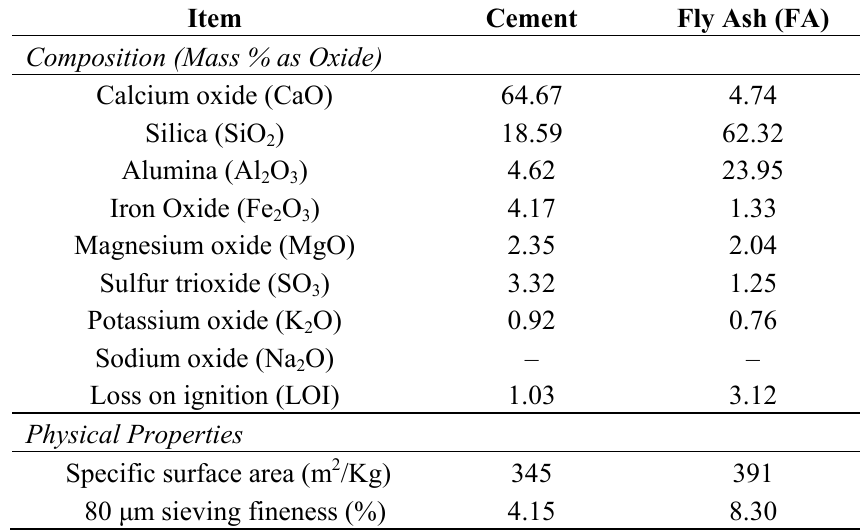
Table 5. Chemical composition and physical properties of the cement and fly